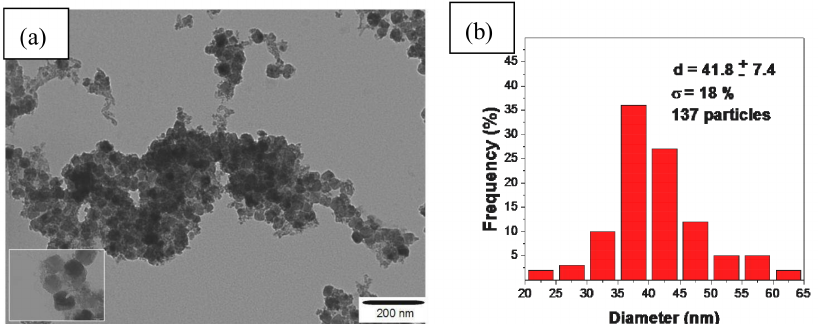
Figure 2. ( a ) Transmission electron microscopy image of the FCo 98 sample; ( b ) histogram of the amount of particles, depending on the size of the nanoparticles of cobalt ferrite.